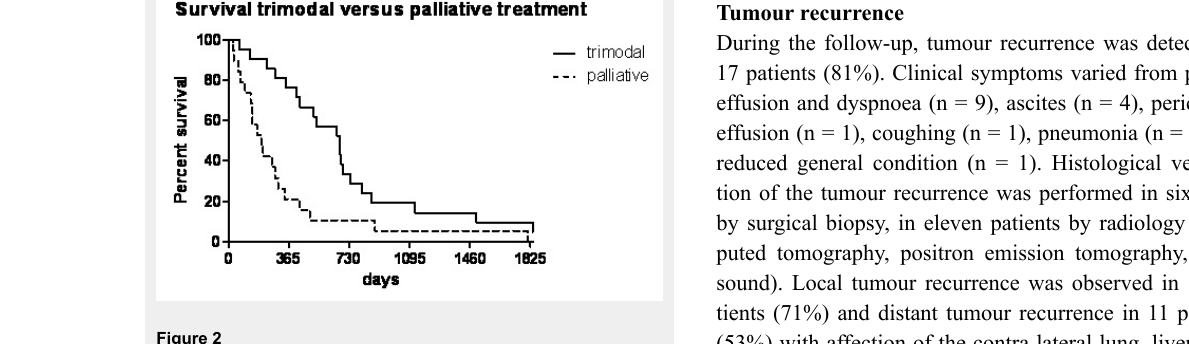
Long-term survival analysis by Kaplan-Meier survival curve of trimodal versus palliative